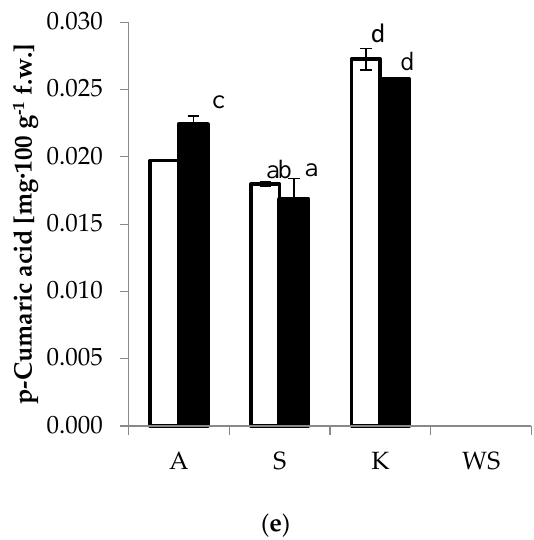
Figure 5. Selected polyphenols in carrot juices. ( a ) Caffeic acid; ( b ) Ferulic acid; ( c ) (+) Catechin; ( d ) Salicylic acid; ( e ) p-Cumaric acid. White bars, CJ and black bars, BCJ). Various types: A, Askona F1; S, Samba F1; K, Kazan F1; WS, White Satin. Mean ± SE, the same letters set no differences at p < 0.05. Table 4. Color parameters of carrot juice depending on the biofortification of carrots and their varieties.